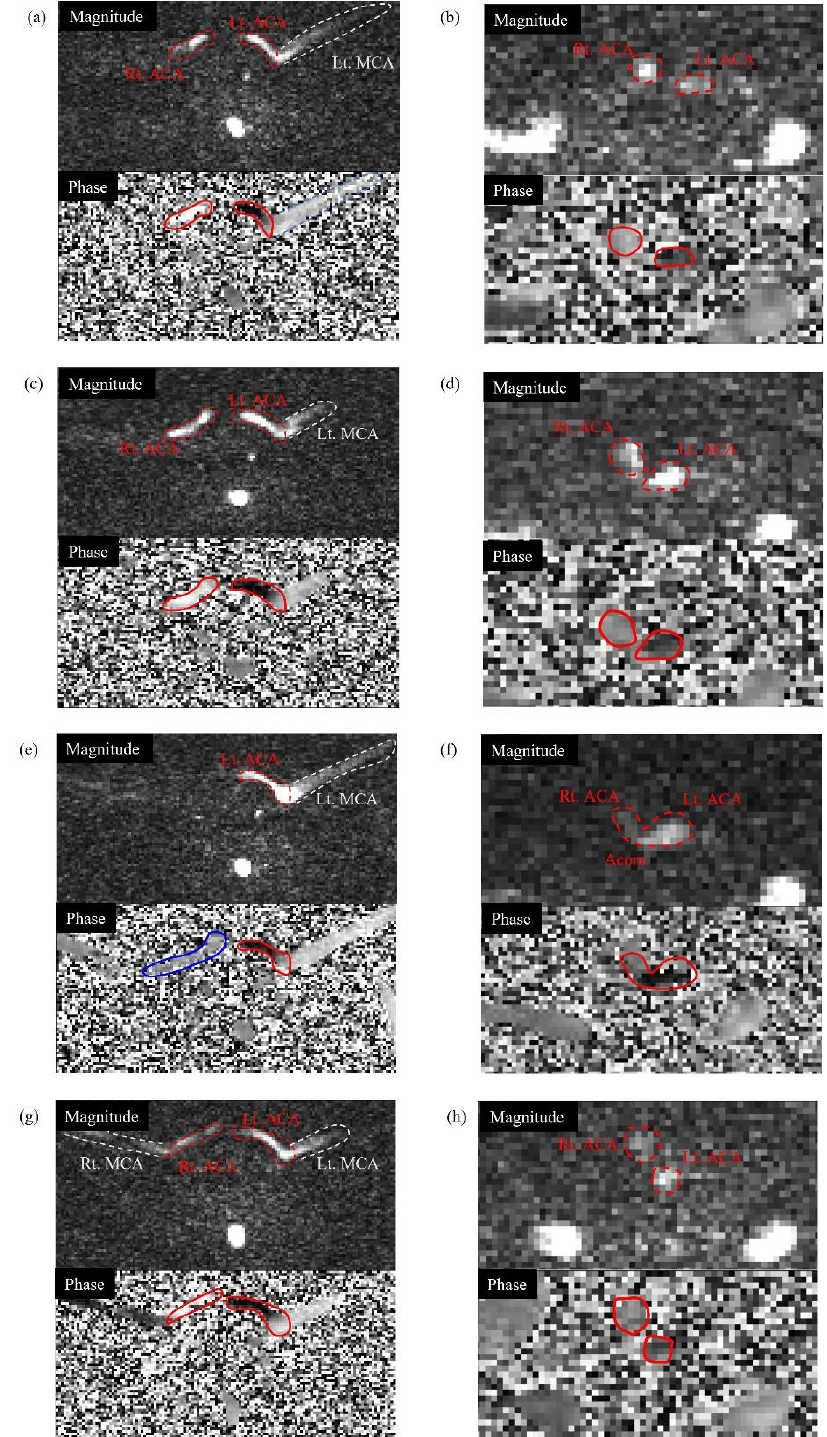
Figure 5. Representative slices for the analysis of the anterior cerebral artery (ACA) and anterior communicating artery (Acom) flow directions at velocity encoding (VENC) = 50 cm/s (magnitude and phase images on the top and bottom, respectively, and images of ACA and Acom on the left and right, respectively): ( a , b ) normal phantom; ( c , d ) right ICA 50% stenosis phantom (ICA50); ( e , f ) right ICA 100% occlusion phantom (ICA100); and ( g , h ) right VA 100% occlusion phantom (VA100). The phase images were obtained from a left – right encoding direction. The red lines represent a normal ACA and Acom flow, and the blue lines represent a reversed flow. The white dotted lines indicate the middle cerebral artery (MCA).